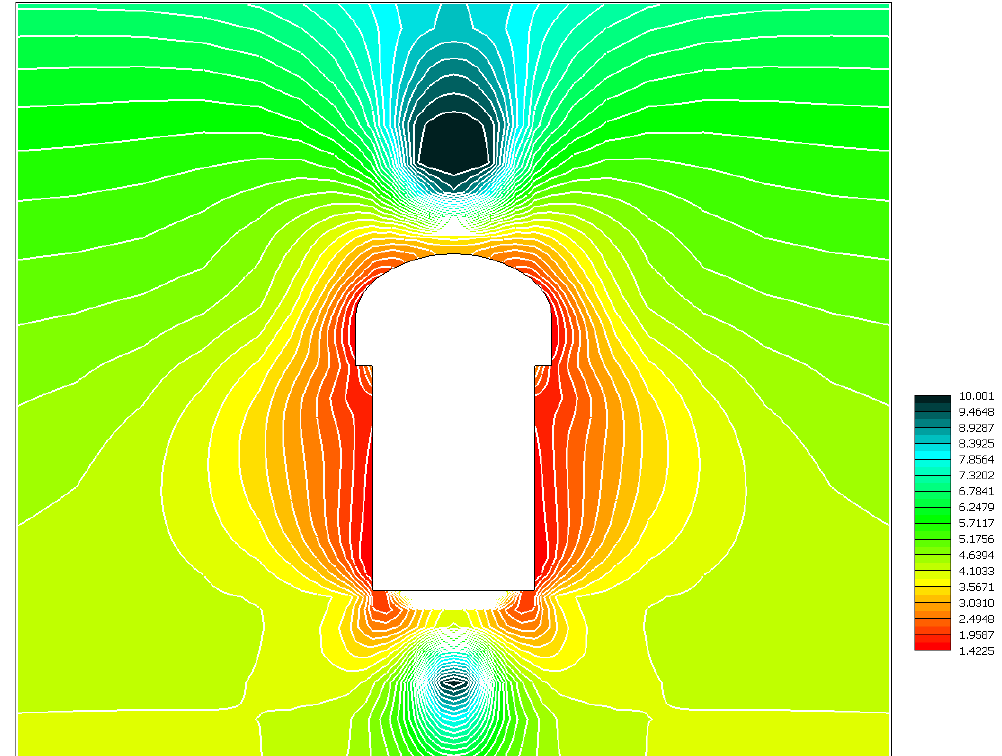
Figure 18. Safety factor distribution (Ko = 0.5).